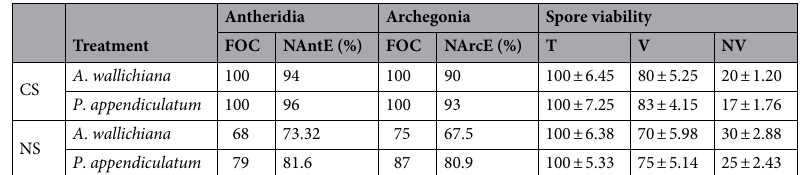
Table 4. Nickel impacts frequency of occurrence of antheridia and archegonia and spore viability in Astrella wallichiana and Plagiochasma appendiculatum . Visible effects of Ni excess (NS, n = 5) observed on frequency of occurrence (FOC) of normal antheridia and archegonia of A. wallichiana and P. appendiculatum compared to control sites (CS, n = 5). Data presented are FOC taking control as 100%. Abbreviations : FOC, frequency of occurrence; NAntE, normal antheridia encounter; NArcE, normal archegonia encounter; T, total spore count; V, viable spore count; NV, non viable spore count. Spore count values represent 100 spore count made per slide, with three independent biological replicates ( n = 3